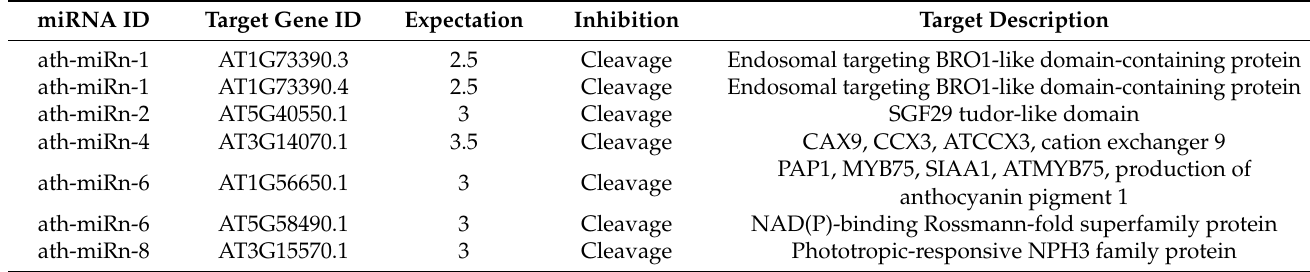
Table 3. Functional annotation of predicted target genes of differentially expressed novel